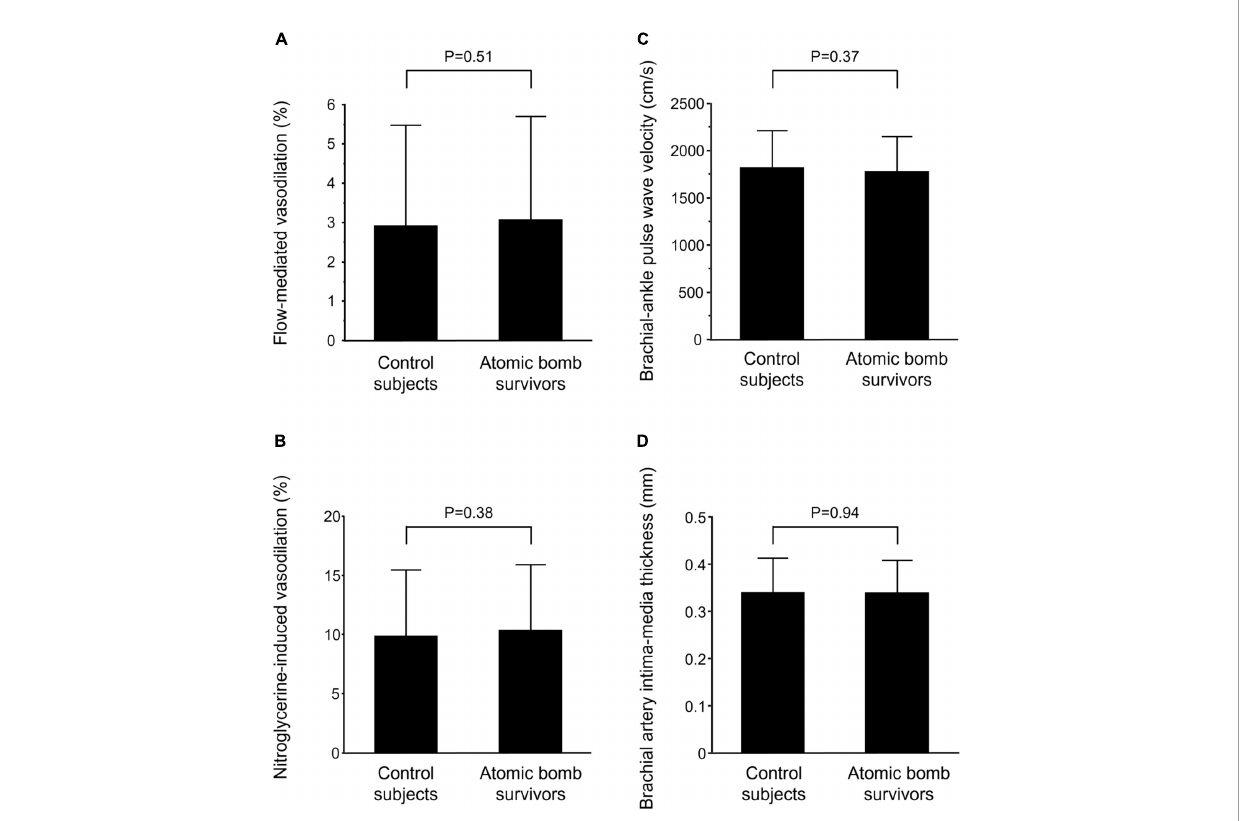
FIGURE1 Bar graphs show flow-mediated vasodilation (A) , nitroglycerine-induced vasodilation (B) , brachial-ankle pulse wave velocity (C) , and brachial artery intima-media thickness (D) in control subjects and atomic bomb